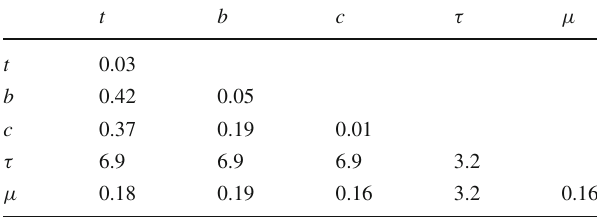
/ Y obs Table 2 Maximal values of Y VIA within the regions that are B B allowed by the LHC and eEDM constraints at 90% CL for all com- binations of the five considered fermion flavors, where the modifiers of up to two couplings are varied. The electron-Yukawa coupling is fixed at c e = 1, ˜ c e = 0. The diagonal entries of the table represent the cases where only one Yukawa coupling is